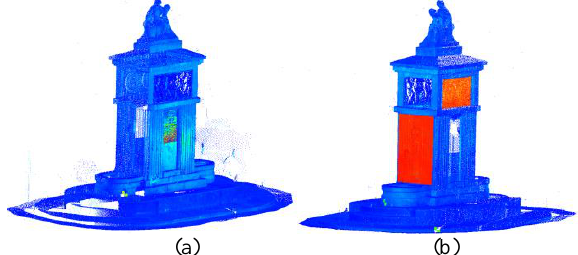
Figure 17. (a) TLS point cloud. (b) Two point patches for validation in red.